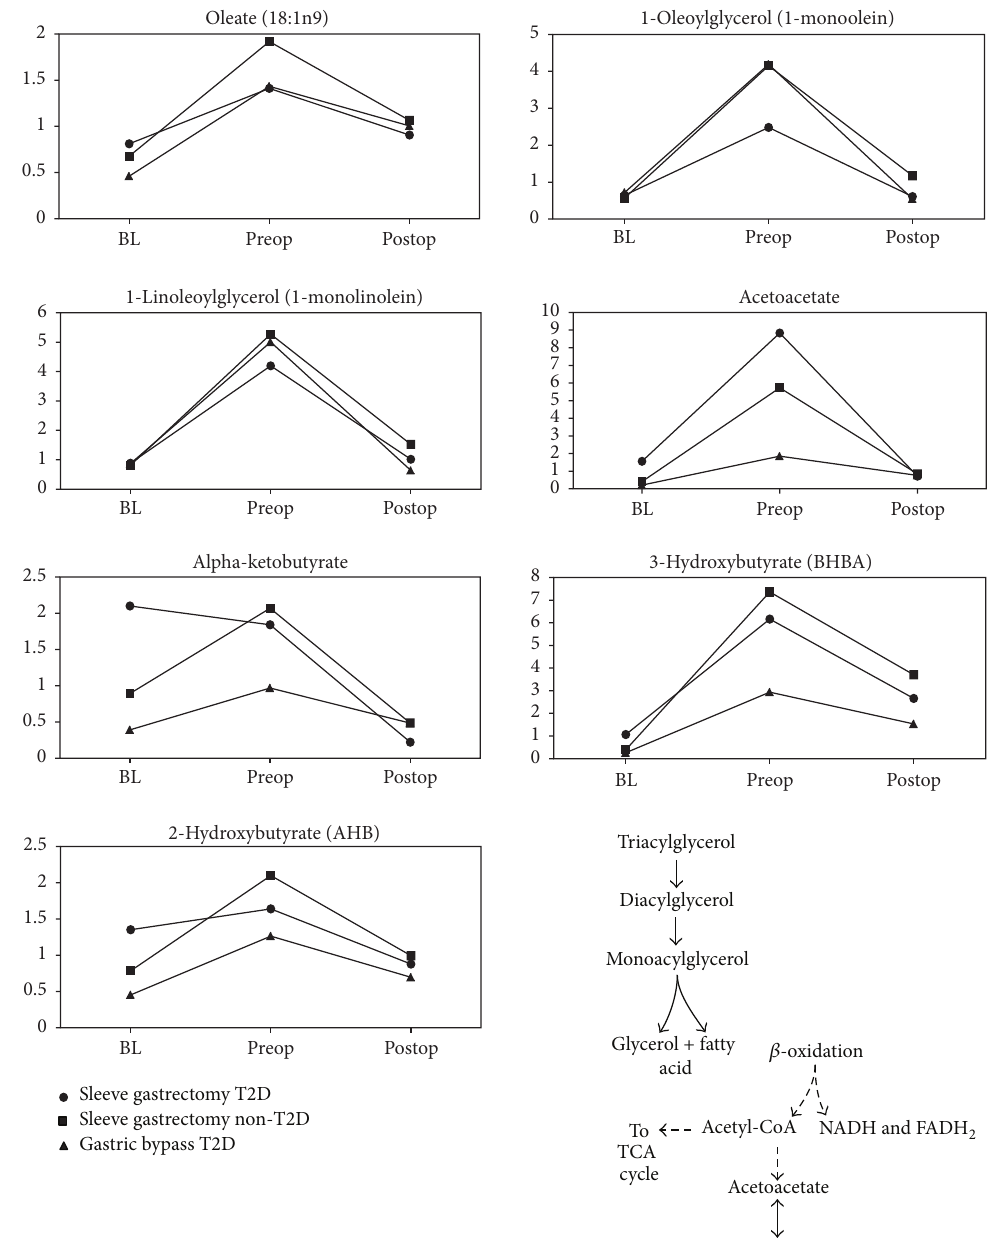
Figure 1: Fat mobilization and oxidation: key signatures associated with preop diet. All shown metabolites meet the conservative criteria of 𝑃 < 0.05 and an estimated false discovery rate of less than 5% ( 𝑞 < 0.05 ).